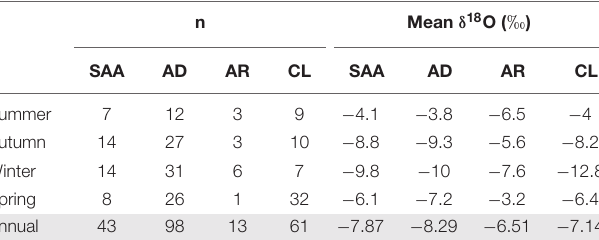
TABLE 4 | Number of events ( n ) and average of δ 18 O values that correspond to the different synoptic patterns (SAA, AD, AR, and CL) analyzed for the 2-year monitoring period (annual) and specified for the different